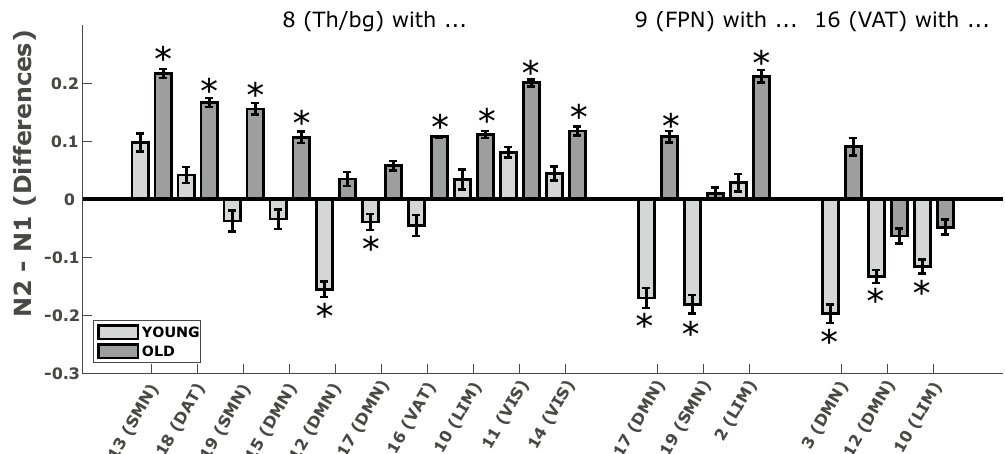
Figure 5. Examples of functional connectivity differences in young and older individuals for N2 vs. N1. This graph is a sample of the connectivity values (R-value; Pearson correlation coefficient) associated with the N2 and N1 comparison between specific clusters and networks that behave differently in young (light grey) and in older individuals (darker grey). Asterisks indicate a significant decrease or increase in functional connectivity for young or/and older groups. Examples of the between-inter networks’ interactions are presented for the default- mode network (DMN), the sensorimotor network (SMN), the dorsal attentional network (DAT), the ventral attentional network (VAT), the frontoparietal network (FPN), the limbic network (LIM) and the visual network (VIS) and thalamus/basal ganglia (Th/bg) clusters (see Fig. 2 and this figure for more details on the subdivision of clusters and for an exhaustive description of functional connectivity